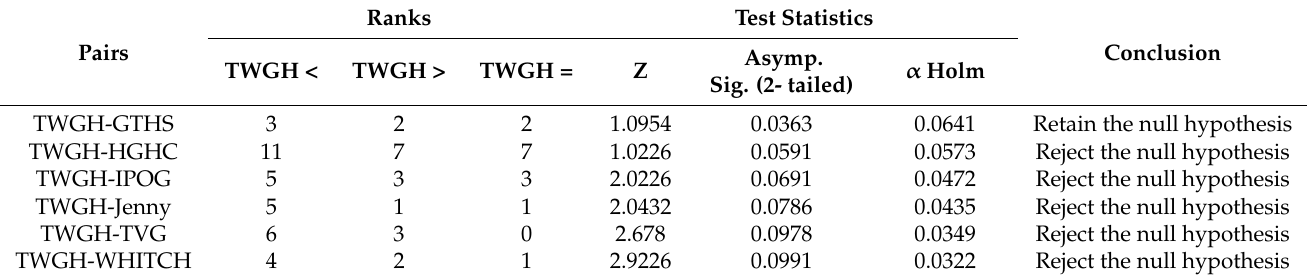
Table 8. Analysis of data from Table 4 using the Wilcoxon signed-rank sum test.